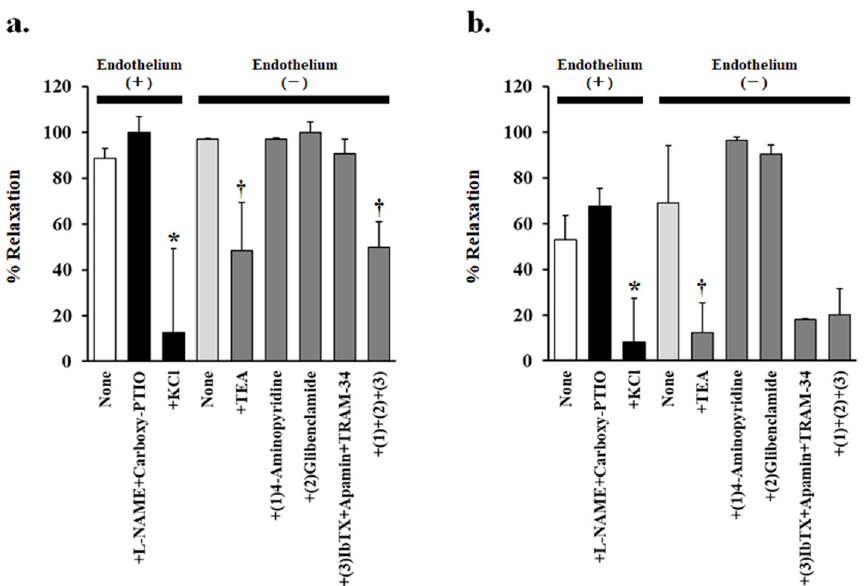
Figure 4. Effects of various inhibitors on ( a ) 0.1 g/L persimmon juice- or ( b ) 0.3 g/L persimmon leaf-induced vasorelaxation in rat superior mesenteric artery rings ( n = 4–6). The inhibitors added were none, NG-nitro-L-arginine methyl ester (L-NAME 1 mM) + carboxy-PTIO (0.1 mM), potassium chloride (20 mM), tetraethylammonium (TEA 1 mM), (1) 4-aminopyridine (1 mM), (2) glibenclamide Results (mean ± standard error of mean) are expressed as a percentage of the previous tone induced by phenylephrine (1 µ M). * p < 0.05 vs. none in the presence of endothelium (Dunnett’s test). † p < 0.05